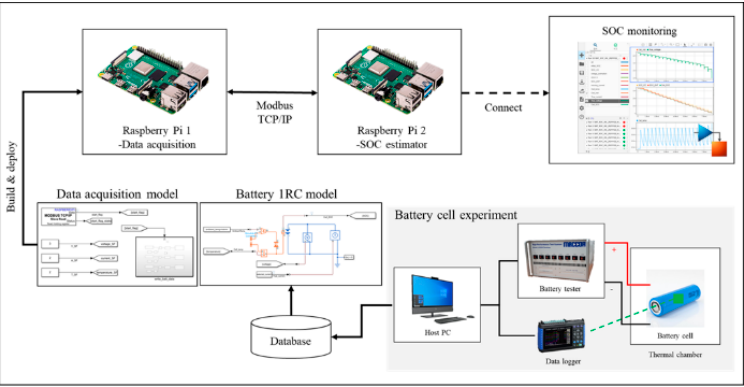
Figure 4. System architecture of SOC estimation using embedded